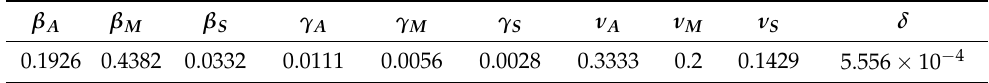
Table A2. Rate parameters used for Figure 4.